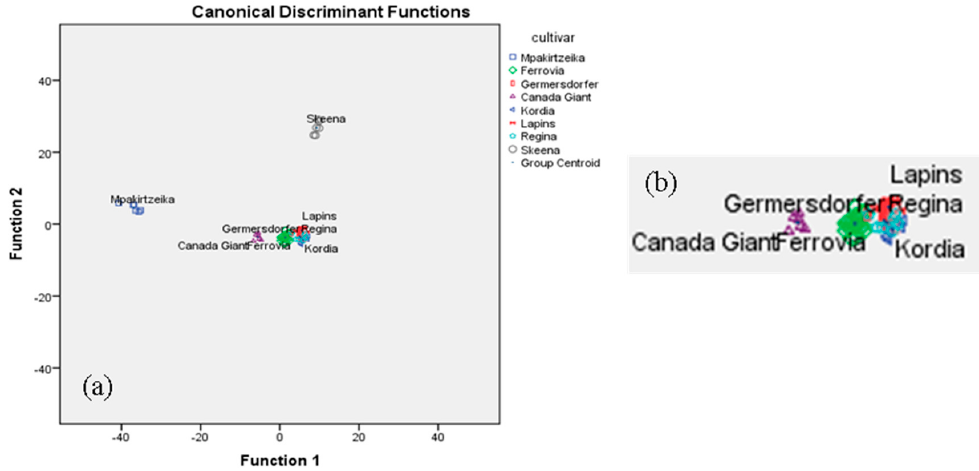
parameters, volatiles, minerals, and sugars; ( b ) blow up of Figure